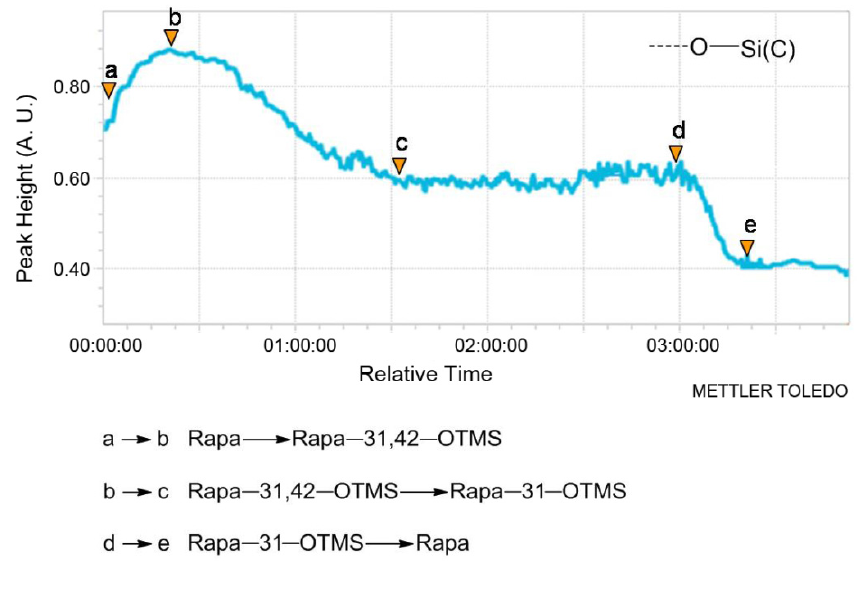
Figure 4. Kinetic profile (peak height vs. time) of the intensity of the absorption peak at 1055 cm − 1 (the characteristic peak attributed to -Si-O(C)) for the reaction of preparation of Rapa-31-OTMS from Rapa. ( a ) Addition of TMSCl and imidazole (00:05:00). SO (00:25:00 to ( b ) Addition of 0.5 N H 2 4